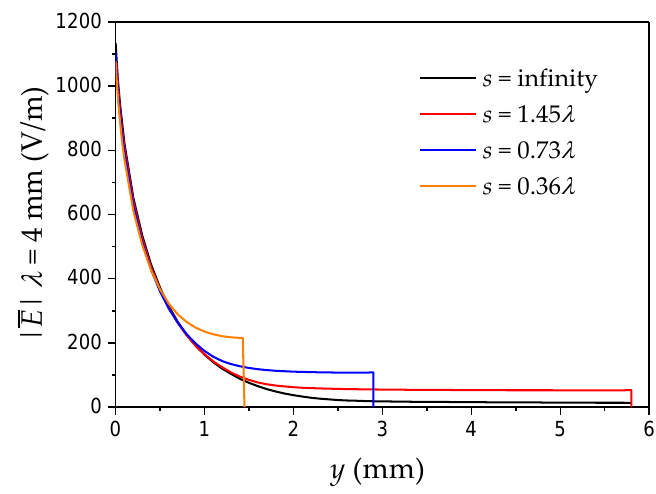
Figure 8. Average electric field strength | E | across the IDS with λ = 4 mm, with a shield distance at 1.45 λ = 5.8 mm, 0.73 λ = 2.9 mm, 0.36 = 1.45 mm and at infinity 2 .